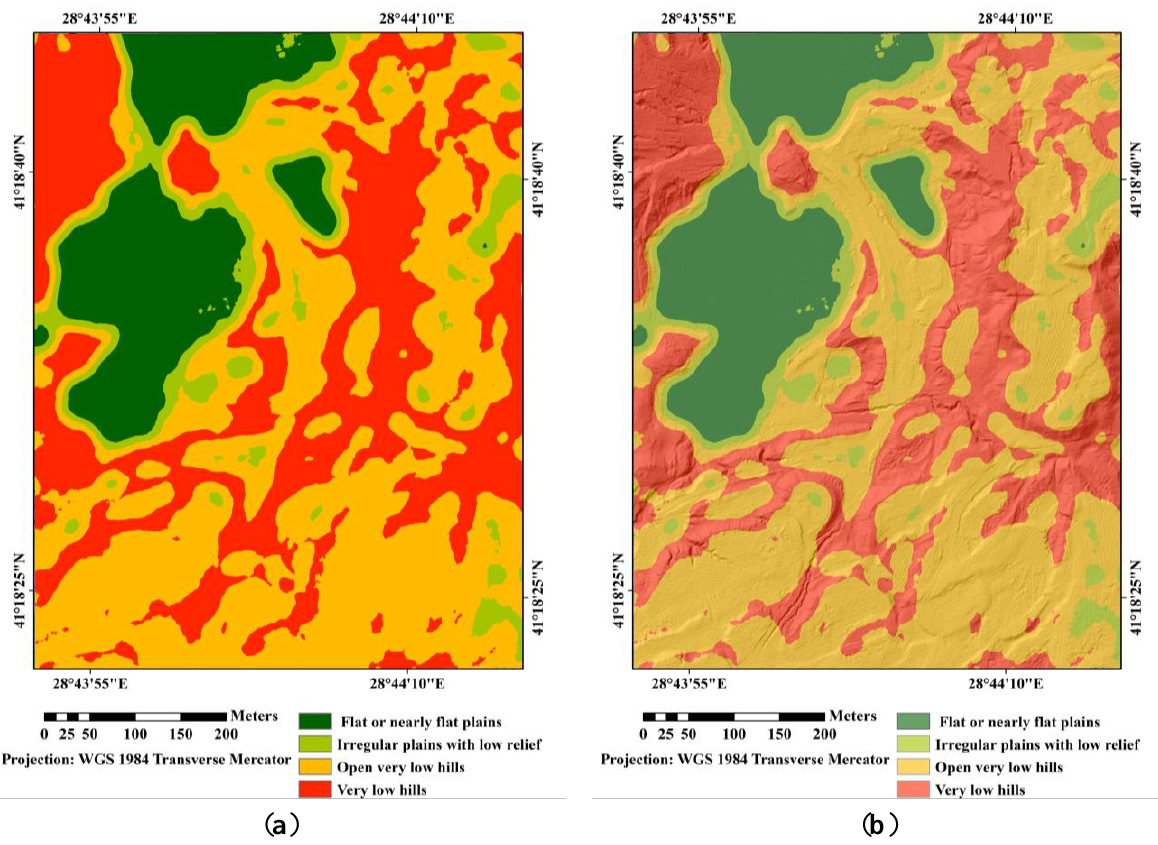
Figure 4. ( a ) Primary landform map; ( b ) Hillshaded primary landform